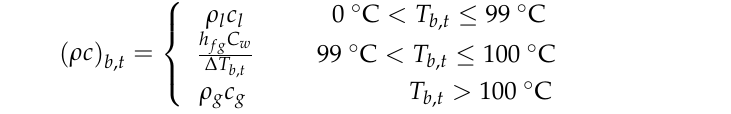
Table 1. The investigated blood vessel diameters and consequent blood flow velocities.